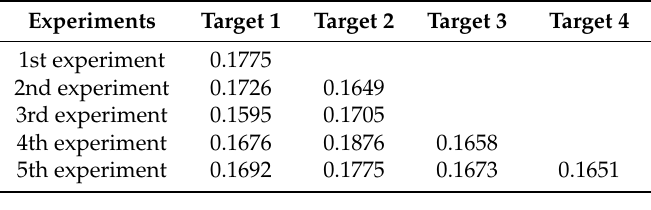
Table 4. Measured root mean square error (RMSE)